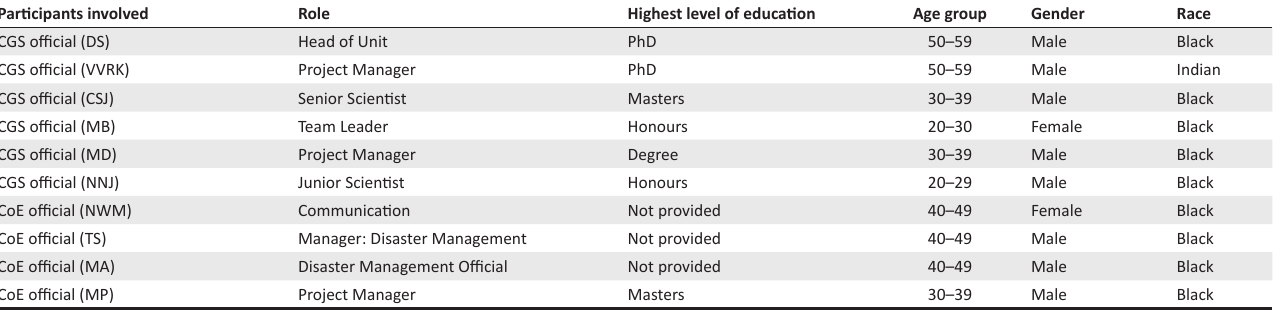
TABLE 1: Characteristics of key participants ( n = 10) in government who participated in the semi-structured interviews. Participants